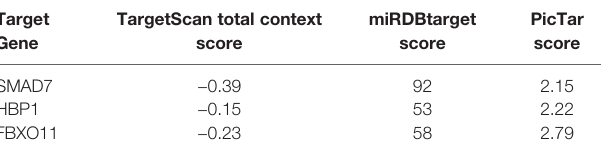
TABLE 4 | Intersection of potential miR-21-3p targets based on analysis of three online